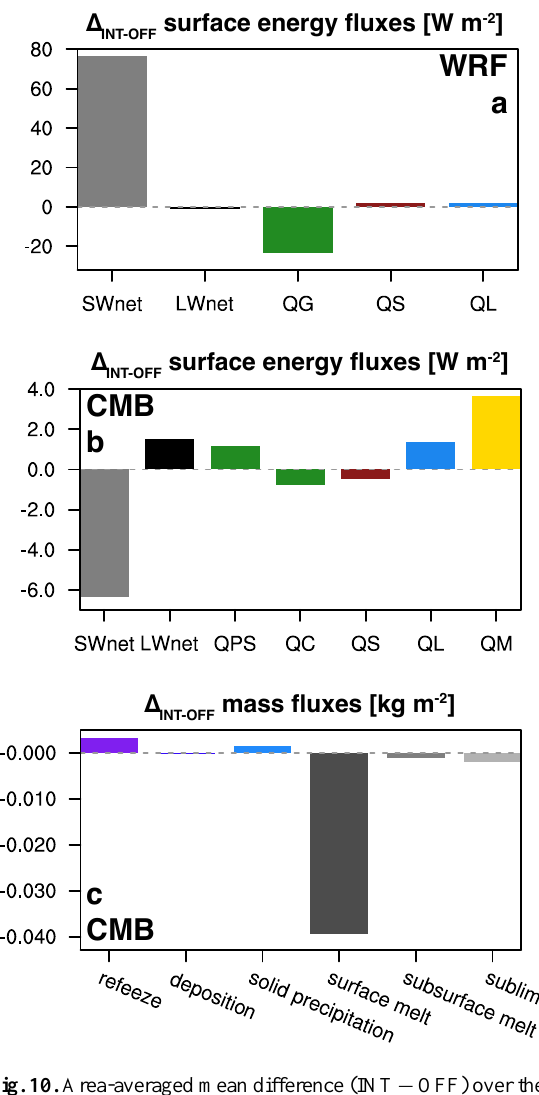
Fig. 10. Area-averaged mean difference (INT − OFF) over the sim- ulation period and over glaciated grid cells of (a) the main compo- nents of the WRF surface energy budget, (b) the MB model energy fluxes, and (c) the MB model mass fluxes. Symbols in (a) repre- sent, from left to right, net short- and long-wave radiation, ground heat flux, and turbulent fluxes of sensible and latent heat. Note that the sign convention for the turbulent fluxes in (a) is opposite to (b) . Symbols in (b) are discussed in Sect.